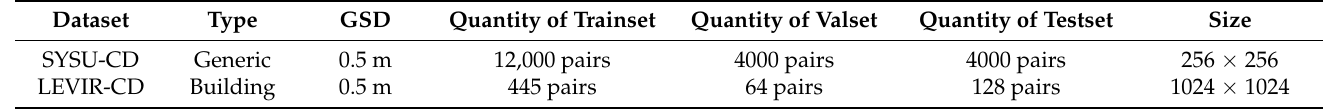
Table 1. Overview of the dataset used in this